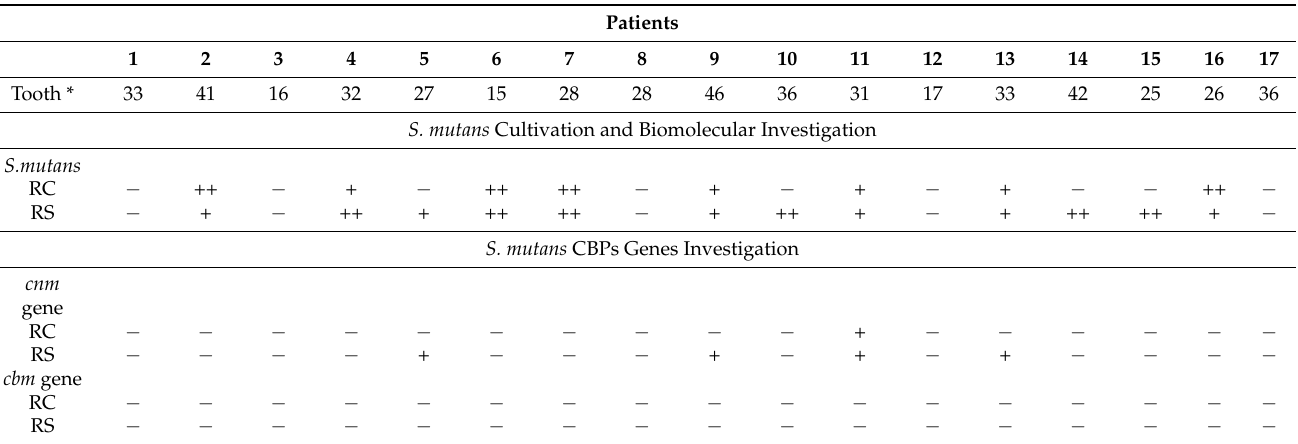
Table 1. Streptococcus mutans and CBP S genes detection by cultivation method and qPCR and PCR, respectively, in teeth extracted from patients affected by